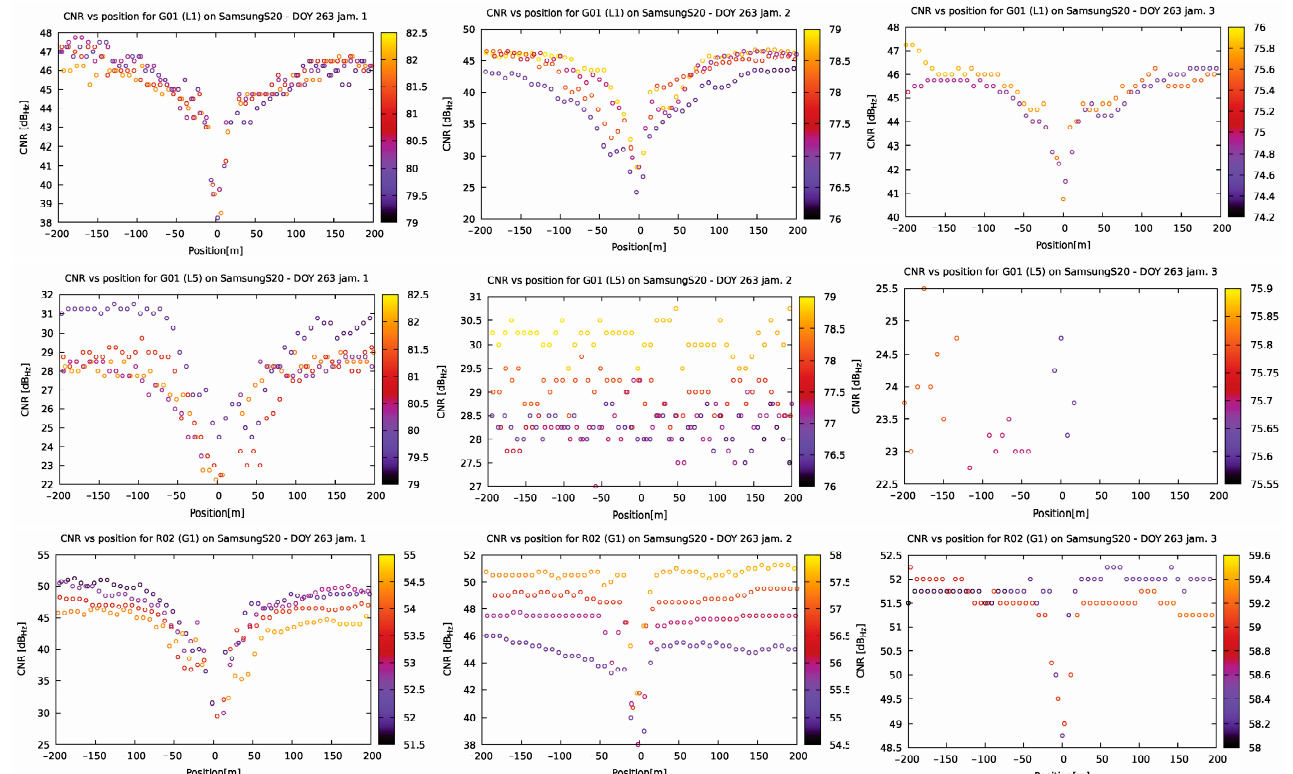
Figure 12. CNR dependence on the position of the jammer (see Figure 11 for an explanation) for various jammers (left column J1, middle column J2, and right column J3) and satellites (lines from top to bottom: C11 on B1, E10 on E1, E10 on E5a, G01 on L1, G01 on L5, and R02 on G1) as acquired by a Samsung S20. The color of the points represents the satellite elevation. The plots are provided here for a broad picture only, and the numbers might appear unreadable. For more detailed plots, please visit https://gnss.fpp.uni-lj.si/2022-09-19 (accessed on 19 February 2022).